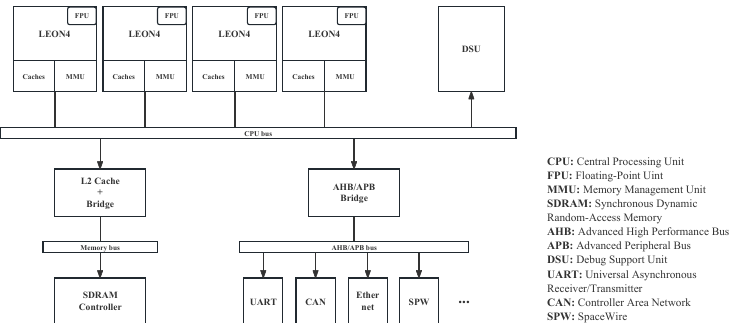
Figure 1. Simplified architecture diagram of GR740.